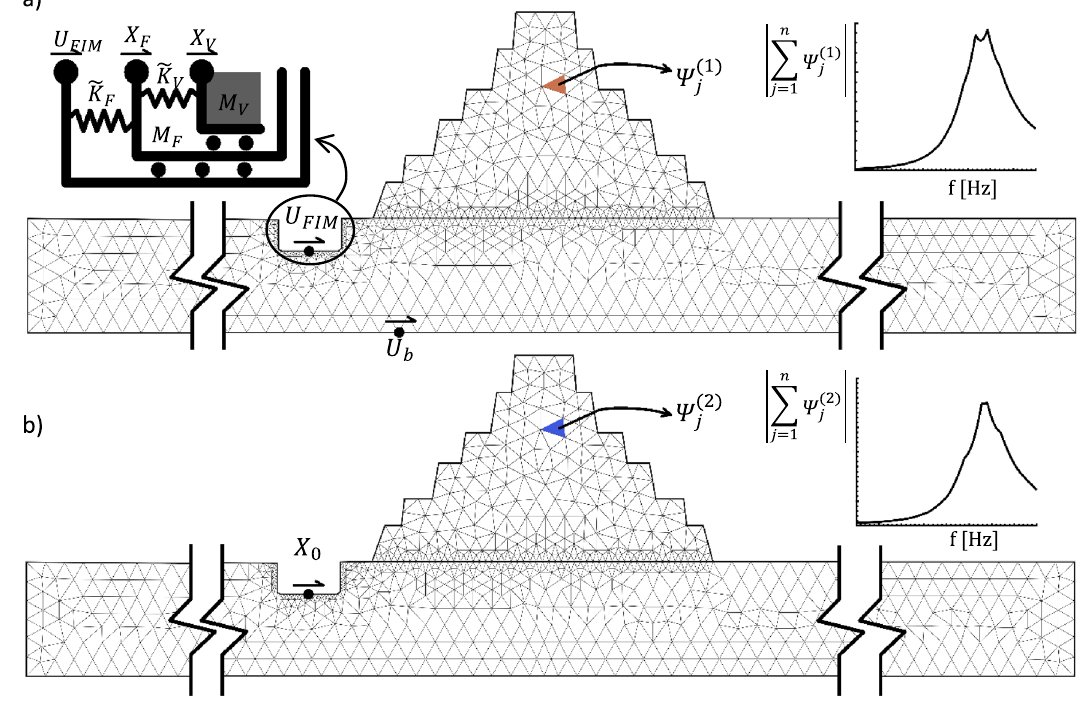
Figure 9. The two sub-domains of the four-step optimal design procedure proposed in this paper. In panel ( a ), the Soil-Pyramid system with the rigid excavation where the ViBa will be installed. The input is applied at the bedrock to derive the interaction between bedrock and foundation input, U FIM as well as the normalized strain energy spectral density of the Pyramid. A close-up of the reduced-order mechanical system used to model the ViBa unit is also shown. In panel ( b ), the second sub-domain is depicted. The input is applied to the centre of rigidity of the foundation (X 0 ) to determine the effect of the ViBa box foundation on the Pyramid dynamic